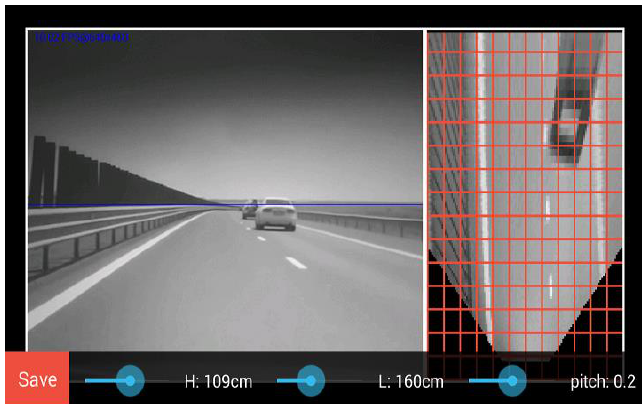
Figure 12. The calibration user interface.